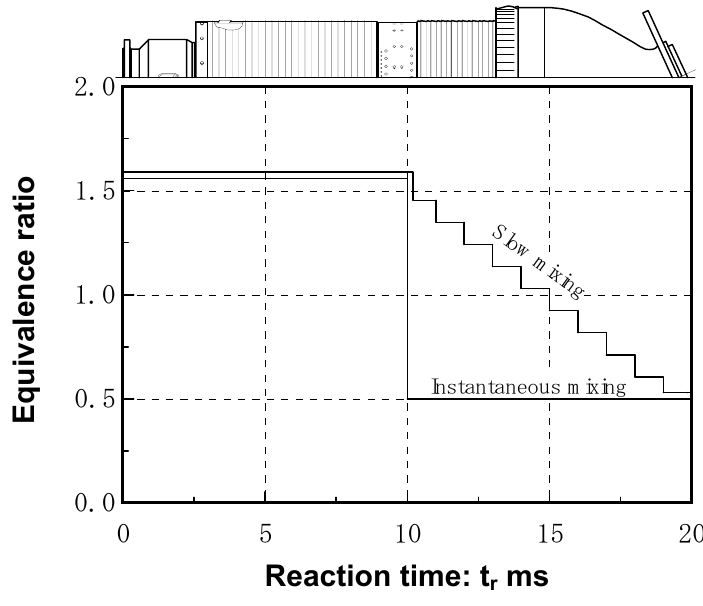
Figure 50. Relation between reaction time and equivalence ratio distribution used in